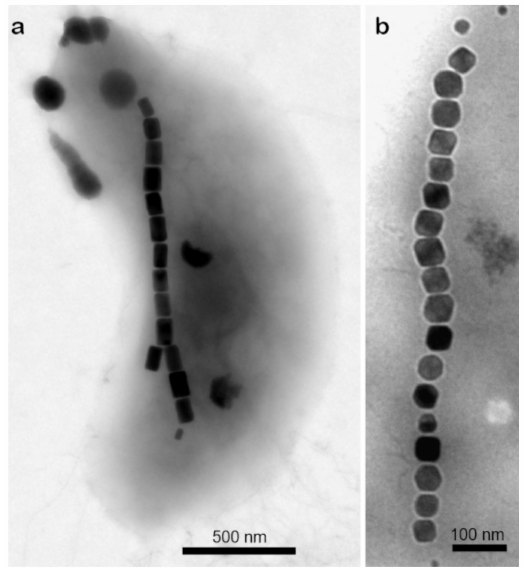
Figure 15. TEM image of ( a ) MTB with a chain of prismatic magnetosomes, ( b ) a chain of magneto- somes with a visible